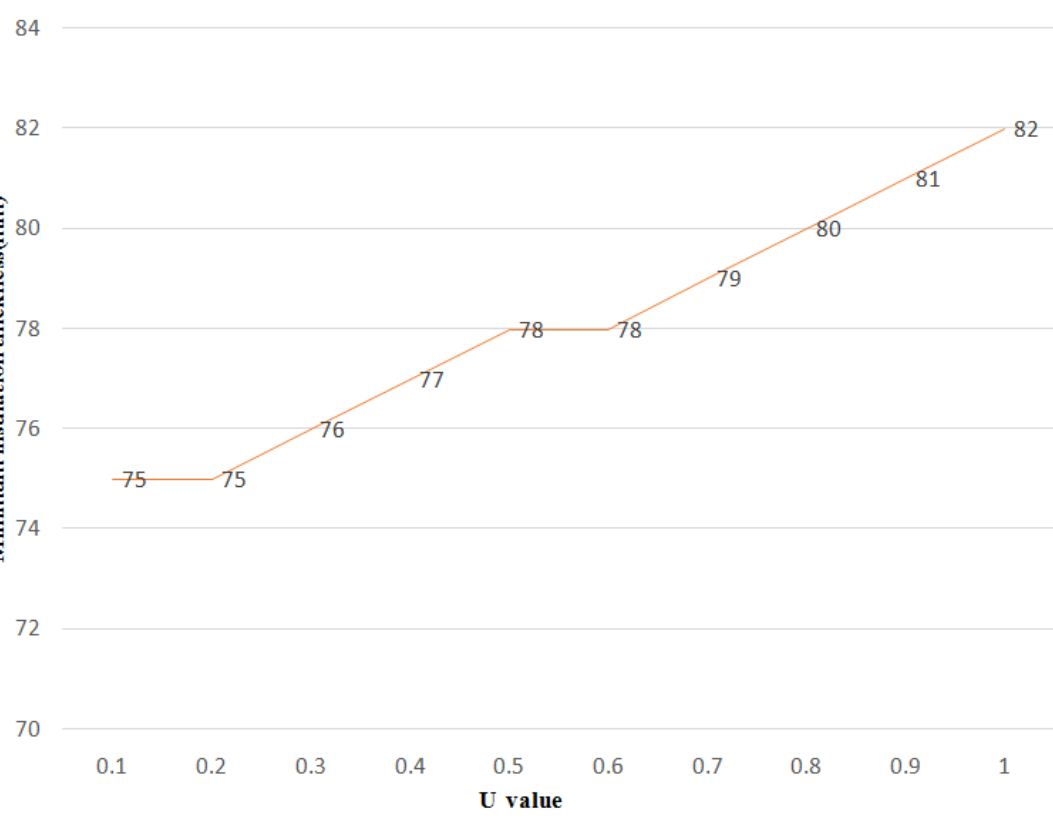
Fig. 5 Relation between frames U value and minimum insulation